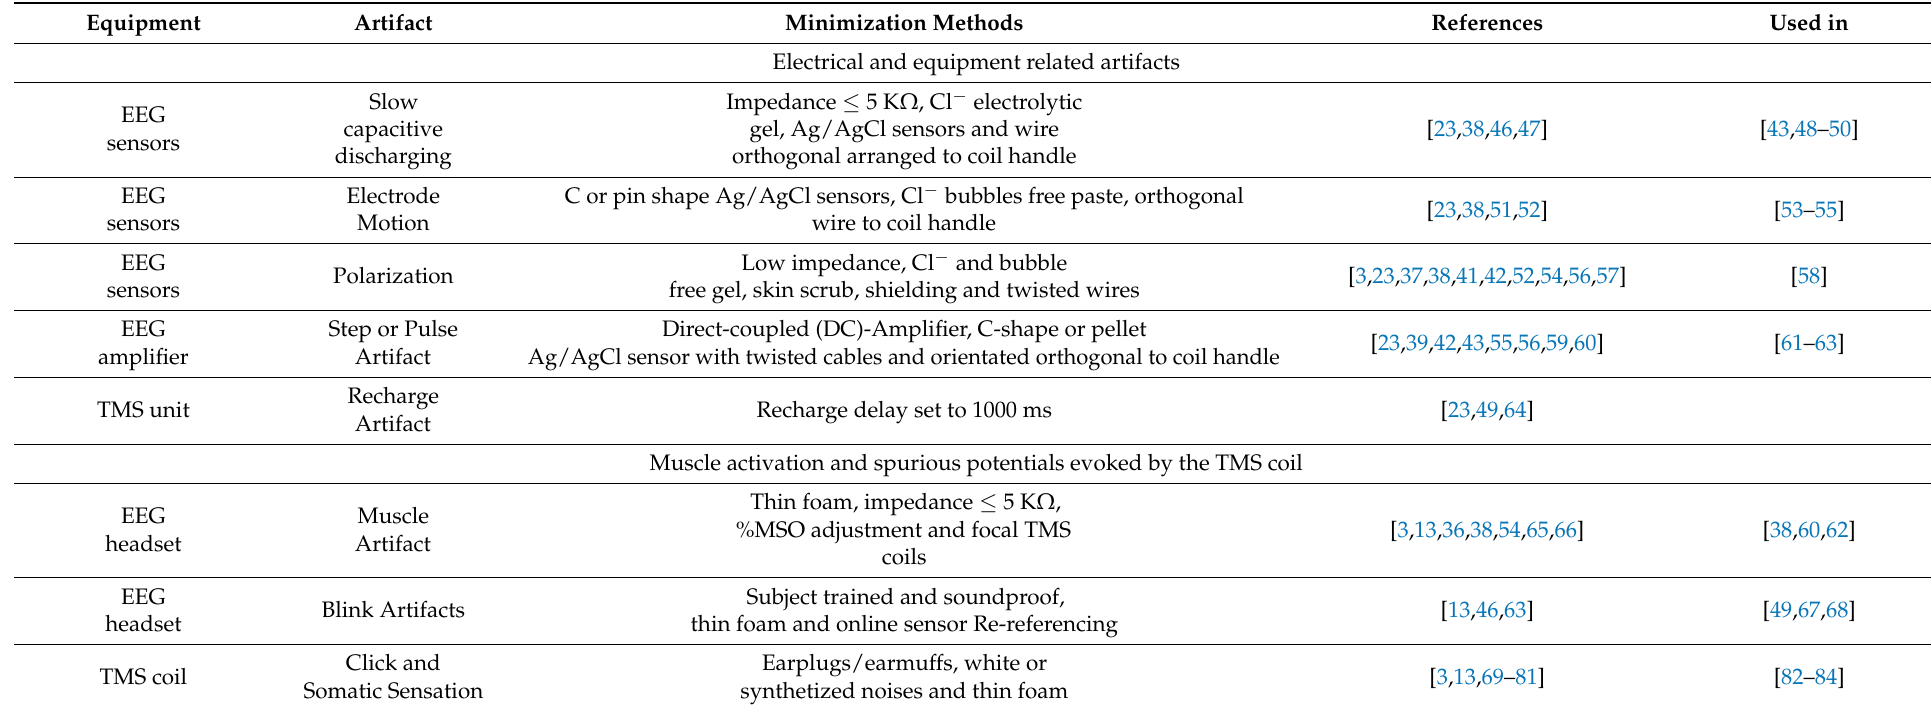
Table 1. Common artifacts in transcranial magnetic stimulation-electroencephalography (TMS-EEG) data and minimization